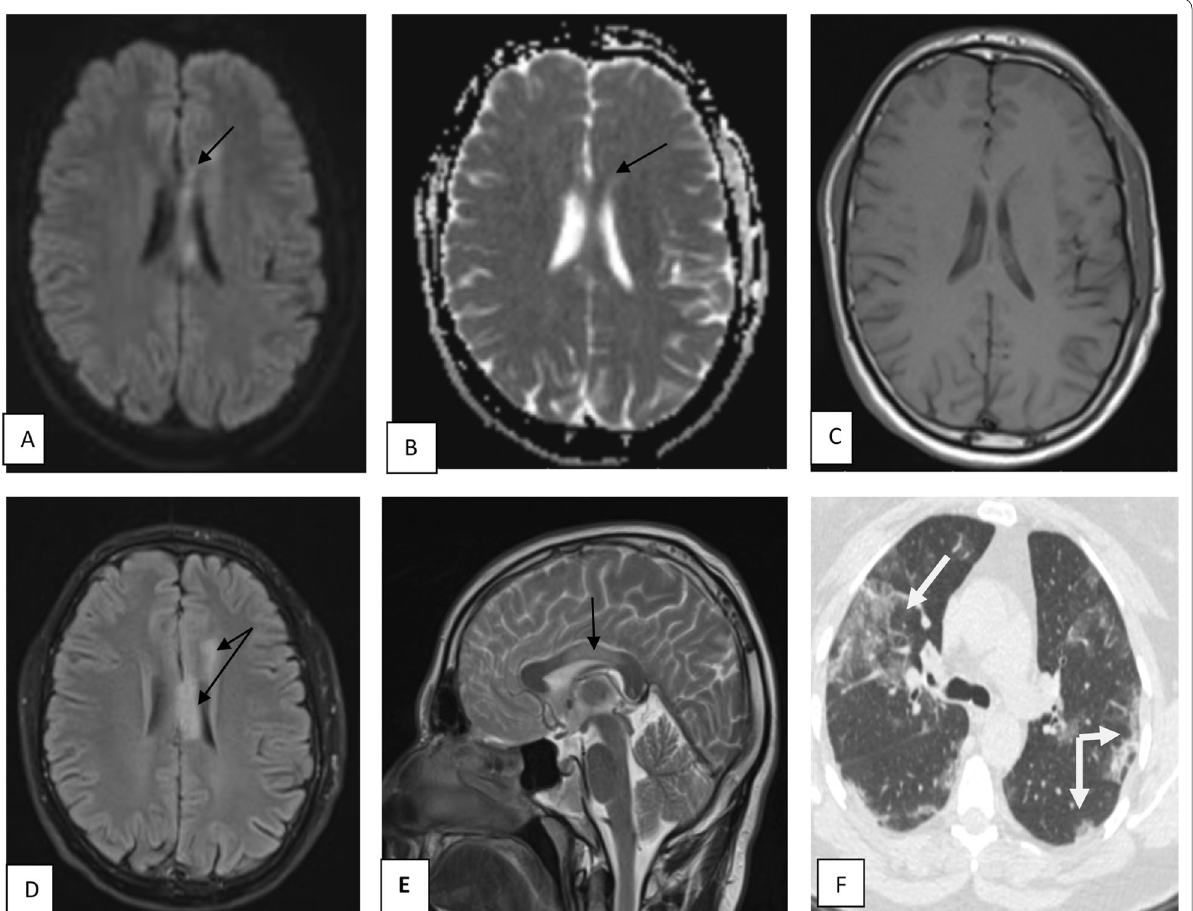
Fig. 8 Male patient aged 29 years old, with history of COVID‑19 infection 1 month ago, presented by headache, weakness in right side of the body and tingling started 3 days ago. MRI brain showed well‑defined callosal and pericallosal left frontal area of altered signal intensity (black arrows) denoting subacute infarction, displaying high signal intensity in DWI ( A ) and intermediate signal intensity in ADC map ( B ) denoting free diffusion. The lesion displays isointense signal in T1WI ( C ) and high signal intensity in FLAIR sequence ( D ) and T2WI ( E ). Axial CT chest cut ( F ) of the same patient shows bilateral peripheral ground‑glass opacities (white arrows) (moderate